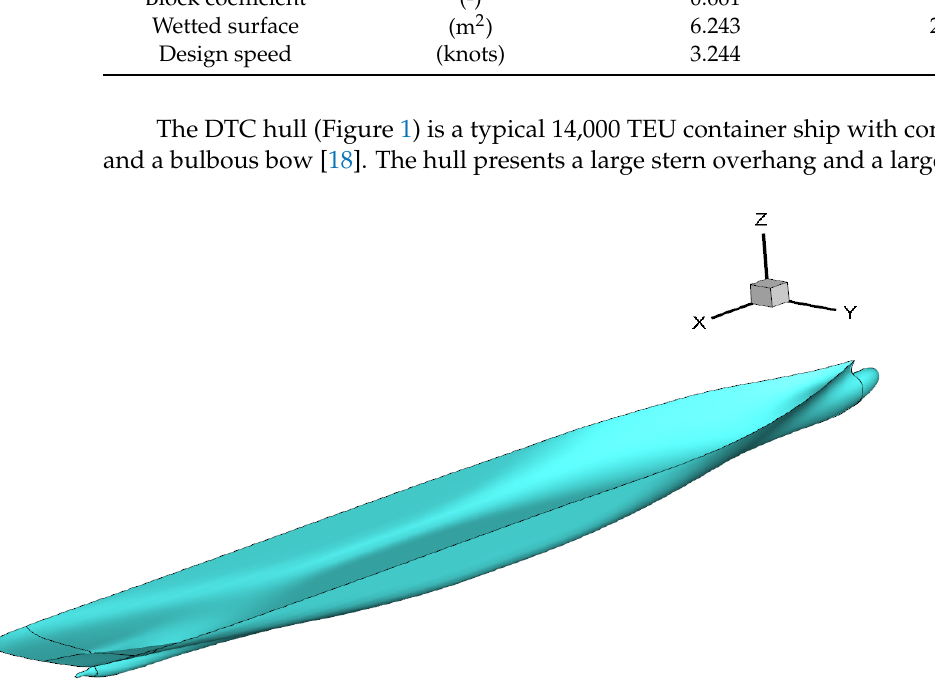
Figure 1. Duisburg Test Case hull.